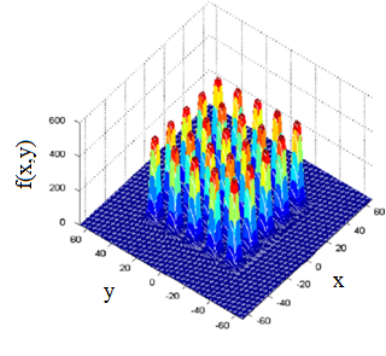
Figure 6: Shekel’s Foxholes function